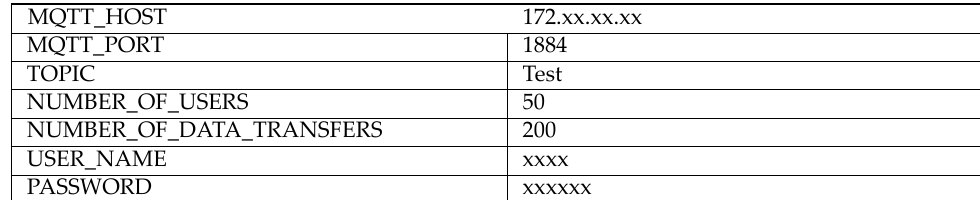
Table 7. Test results during 10 times of repetition.